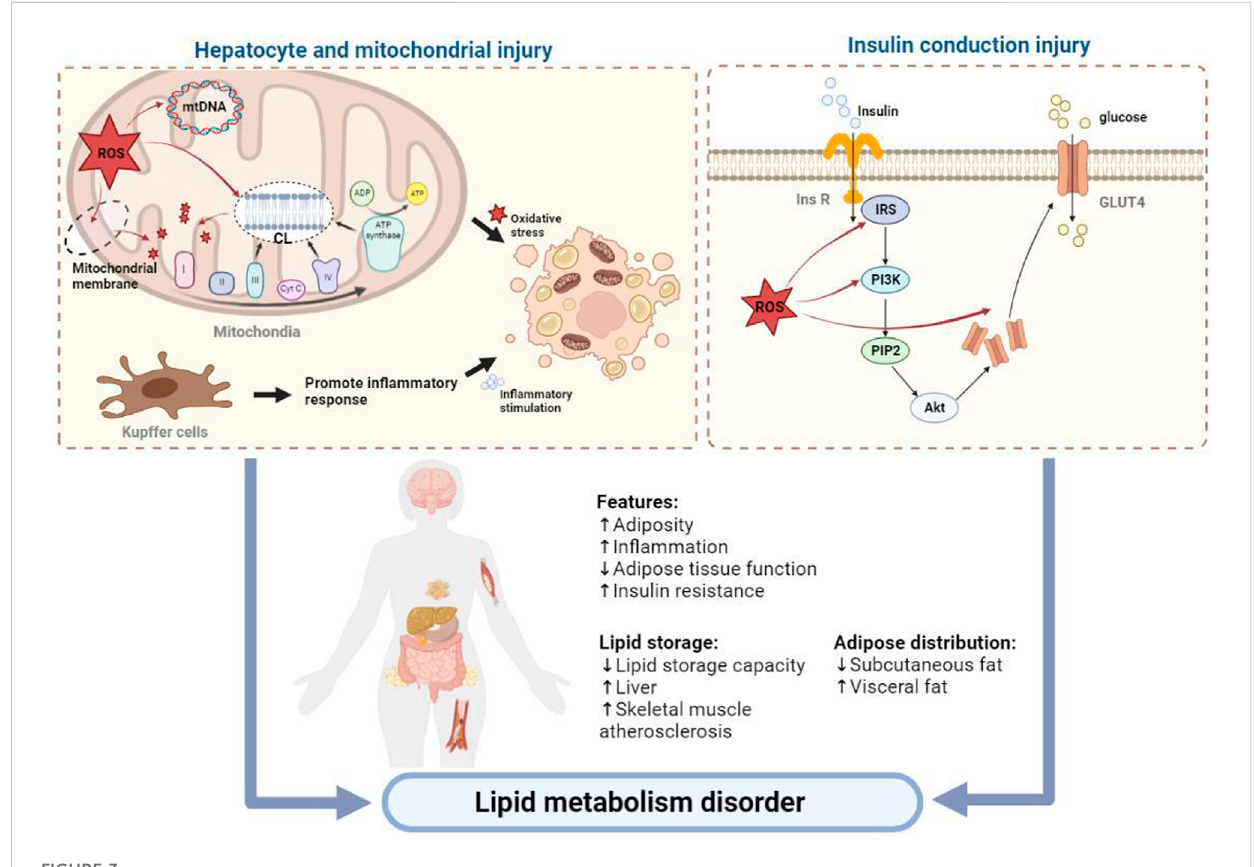
FIGURE 3 Related mechanisms of oxidative stress affecting body lipid